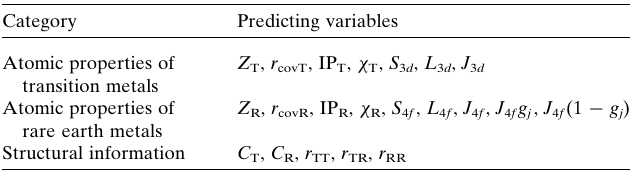
Table 4 The designed predicting variables describing the intrinsic properties of the constituent elements and the structural properties in the T C value prediction for the rare earth–transition metal alloys problem. Category